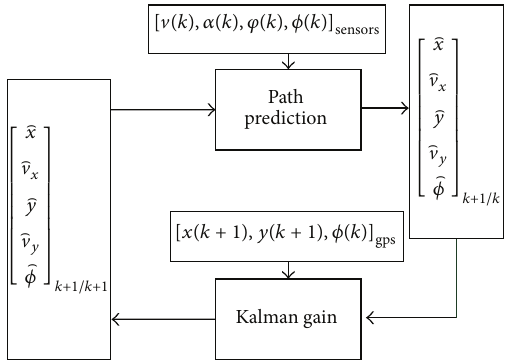
Figure 1: The vehicle position Kalman filter prediction